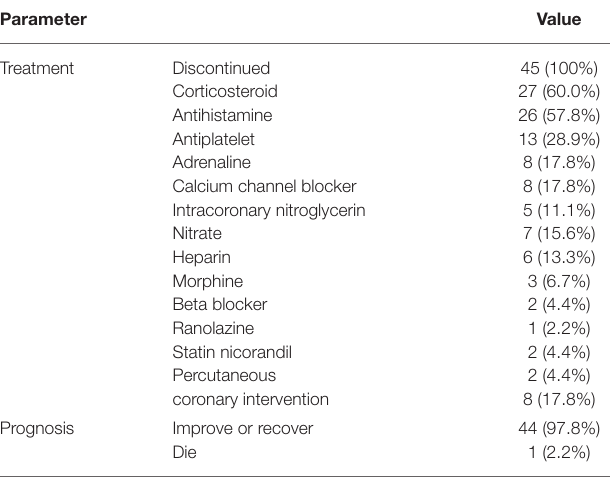
TABLE 4 | Treatment and prognosis of NSAIDs-induced Kounis